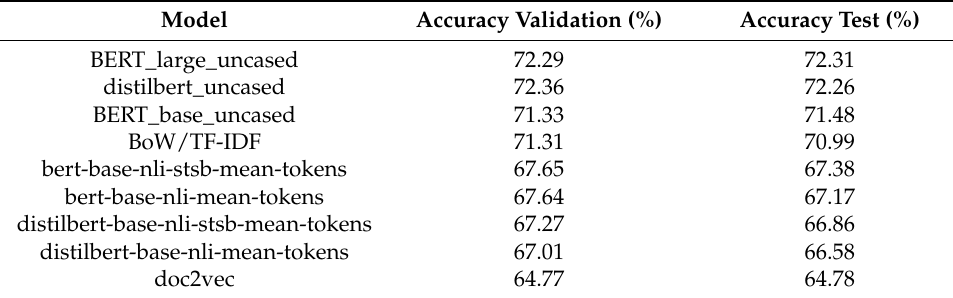
Table 2. Prediction of trust through text.